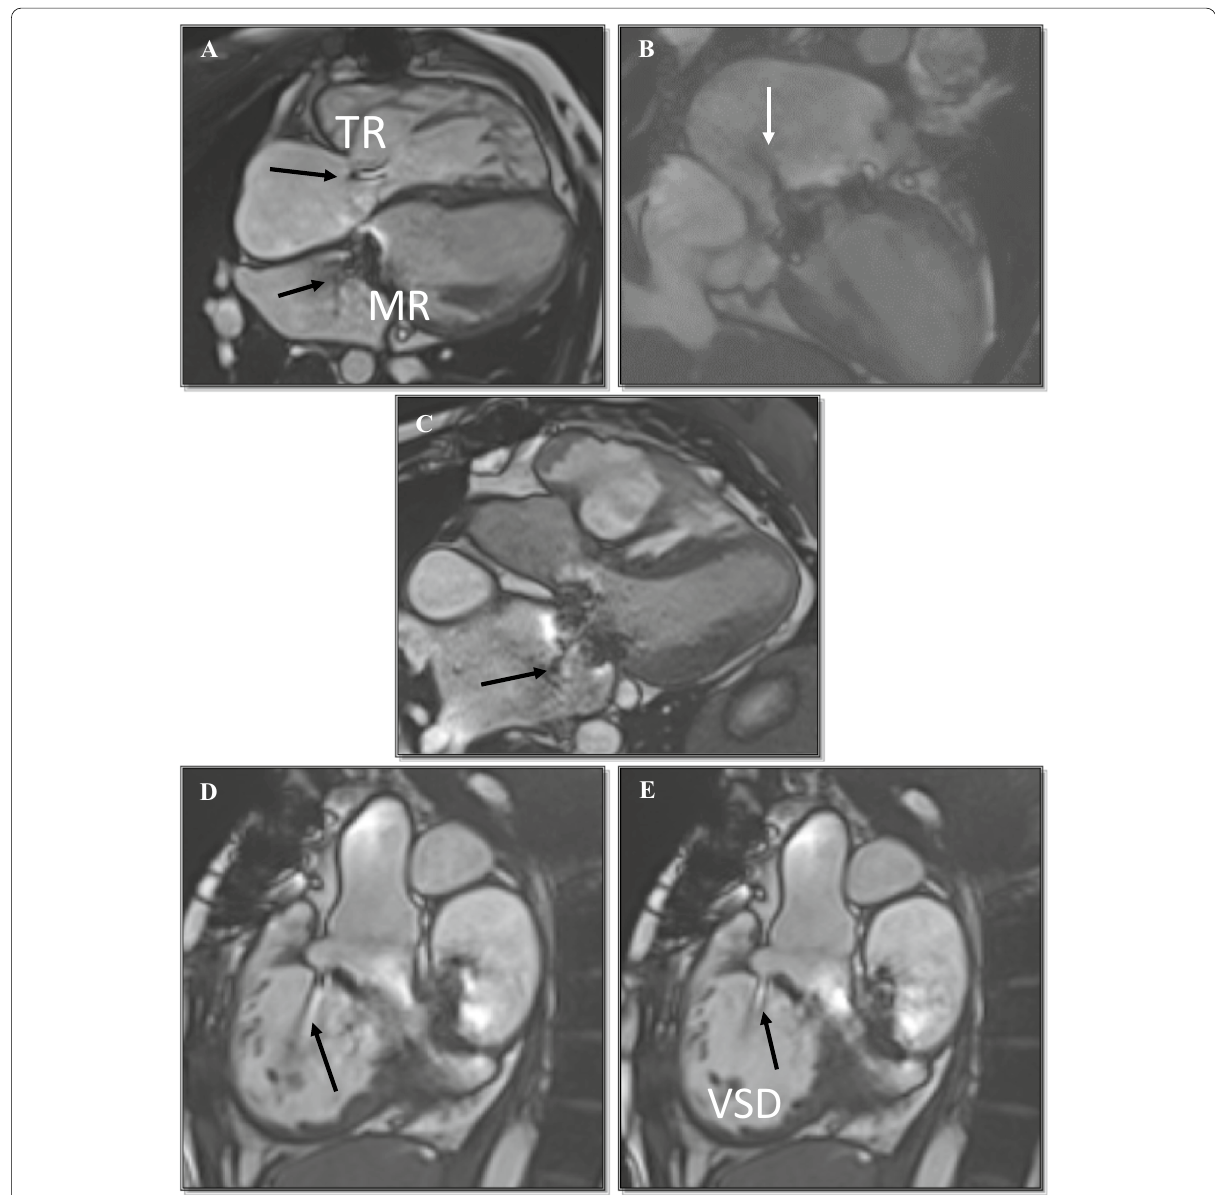
Fig. 3 A – Q CMR revealed: Dilated RV with fair systolic function, preserved LVEF, moderate PR, RF 36%, residual PS with maximum = velocity 3.5 m/s, RPA branch stenosis 3 m/s and LPA branch stenosis 2.5 m/s, mild TR, moderate MR, residual VSD with Qp/Qs 1.5:1. A 23-year-old = = female patient, diagnosed as tetralogy of Fallot, underwent RVOT repair at age of 1-year-old and mitral valve replacement as well. The patient was referred for RV volumes, function and Qp/Qs quantification. A , B , C 4-chamber cine, left 2-chamber cine and left 3-chamber cine images showing mild tricuspid regurgitation and moderate mitral regurgitation on top of mitral valve replacement. D , E , F Three sequential images from VSD cine showing the systolic jet through the VSD. G , H Coronal pulmonary cine images during systole showing stenotic jet and during diastole showing dephasing regurgitant jet. I Sagittal pulmonary in-plane phase-contrast velocity encoding sequence (phase) showing aliasing across the pulmonary valve at Venc 2.5 m/s needing increasing the Venc for optimal flow assessment. J , K Coronal pulmonary in-plane phase-contrast velocity encoding sequence (magnitude and phase) showing no aliasing across the pulmonary valve at Venc 3.5 m/s denoting optimal Venc for optimal flow assessment. L , M , N , O Sagittal phase-contrast velocity encoding sequences in-plane RPA and LPA (anatomy and phase images) with Venc 2.5 and 2 m/s, respectively, showing aliasing across phase images of both denoting pulmonary branches stenosis and so the need to increase Venc for proper assessment. P , Q Feature-tracking analysis of short-axis mid-ventricular level and 4-chamber cine in the form of LV endocardial and epicardial contouring as well as RV endocardial contouring, LV circumferential strain ( 12.3%), RV circumferential strain ( 8.6%), radial strain LV (20.2%), LV − − longitudinal strain ( 14.9%) (4chamber), RV longitudinal strain ( 10.3%), (low feature-tracking RV and LV strain − −